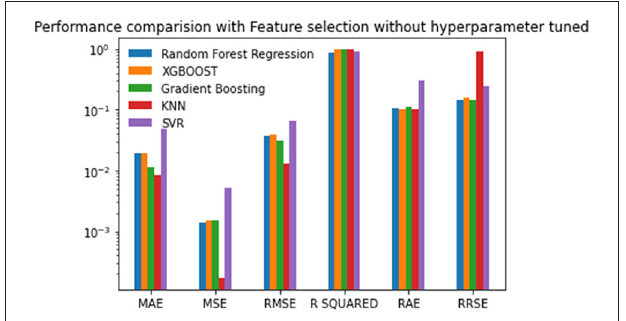
FIGURE 4 | Performance comparison graph of regression techniques with feature selection algorithm and without hyperparameter